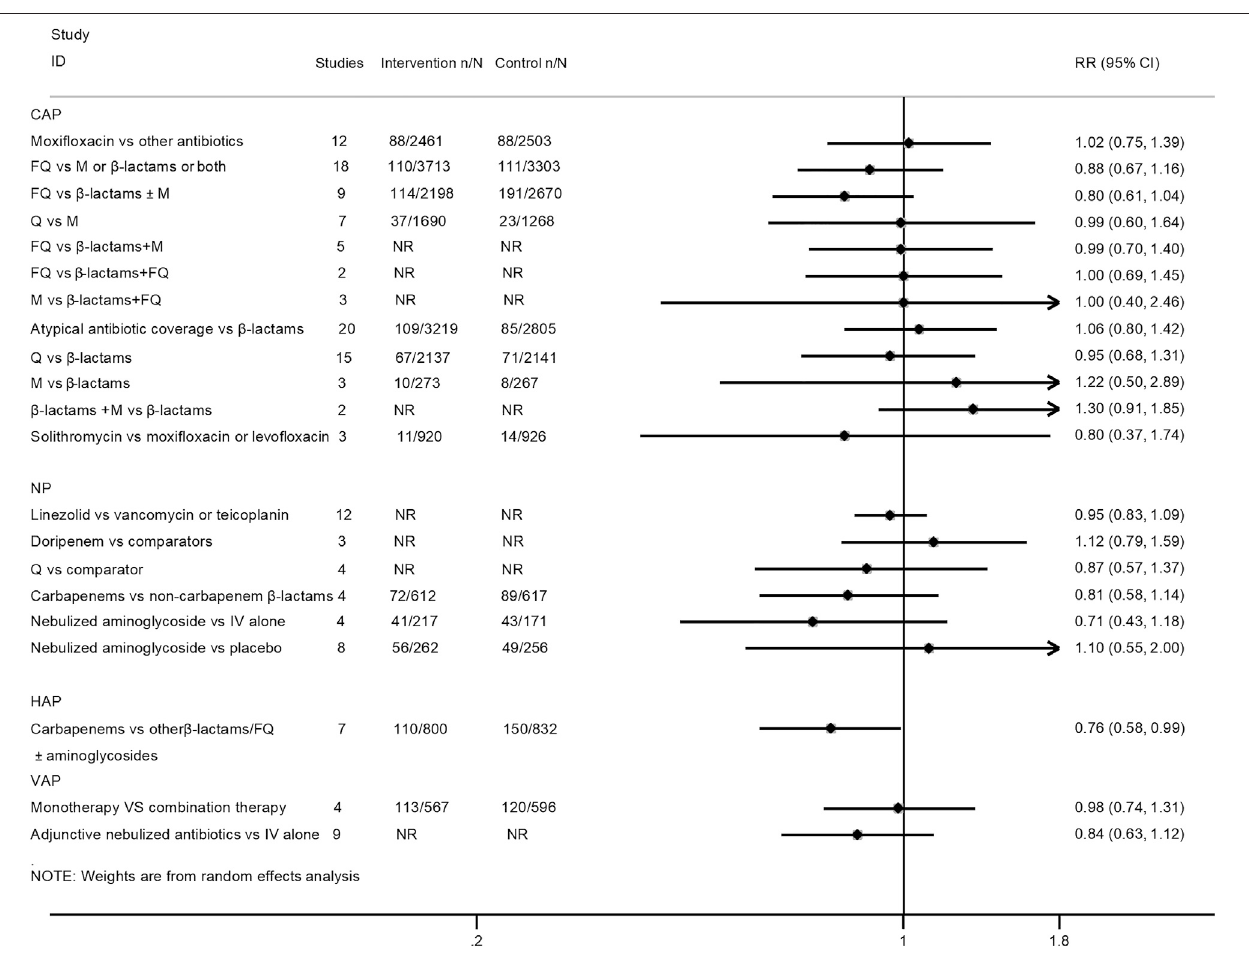
FIGURE 2 | Effects of different antimicrobial therapy strategies on all-cause mortality.